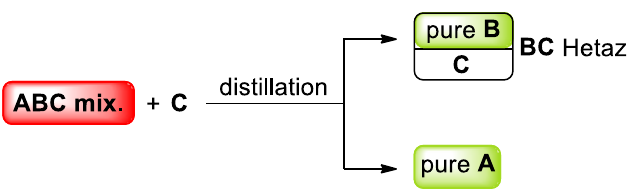
Figure 2. Simplified representation of extractive-heterogeneous azeotropic distillation.